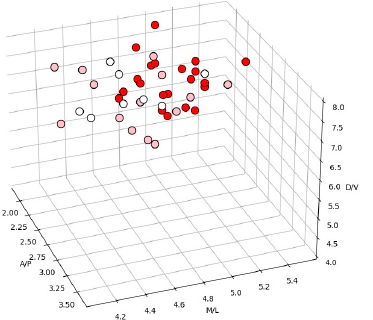
Figure 1. Color-coded visualization of SD occurrence for different locations of intra-amygdala injuries. The red, pink and white dots mark 100% (2/2), 50% (1/2) and 0% (0/2) occurrence of injury-induced SD in two repeated